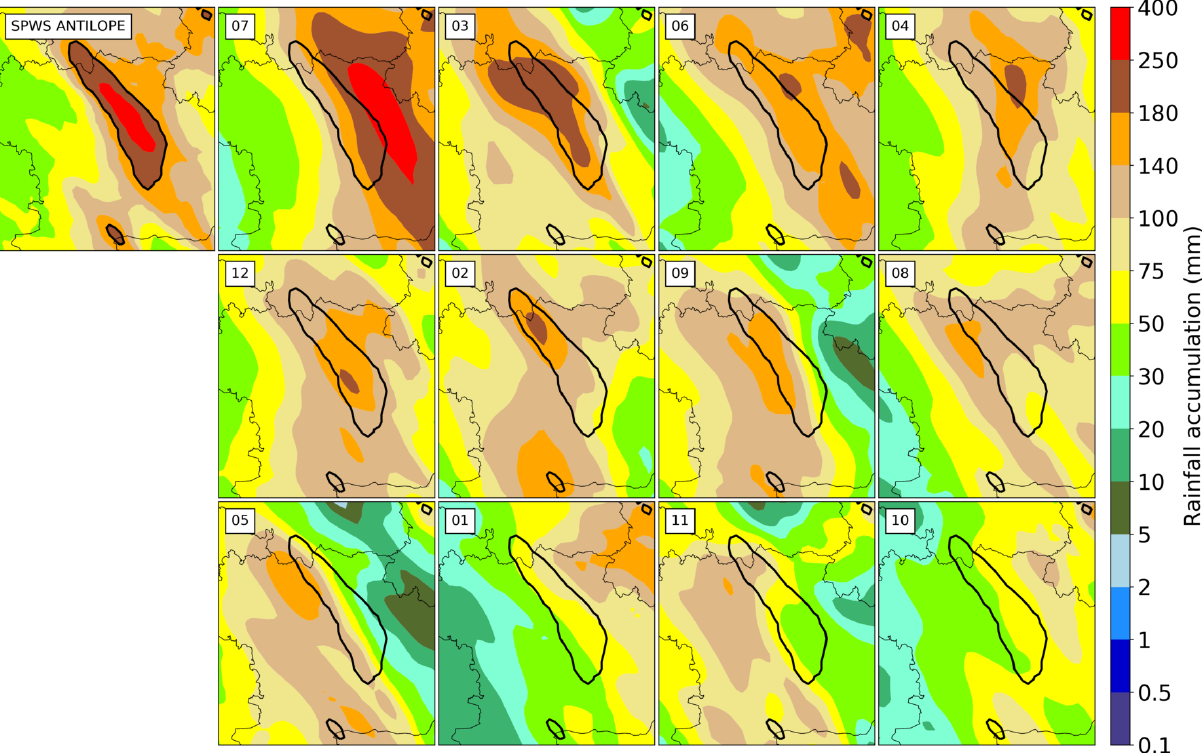
Figure 9. Rainfall accumulation over the period of interest observed by SPWS ANTILOPE and predicted by the 12 members of the AROME- EPS run starting at 15:00UTC on 14 October. Members are ranked by decreasing FSS (from left to right and from top to bottom). The black contour delineates areas where SPWS ANTILOPE observed rain exceeds